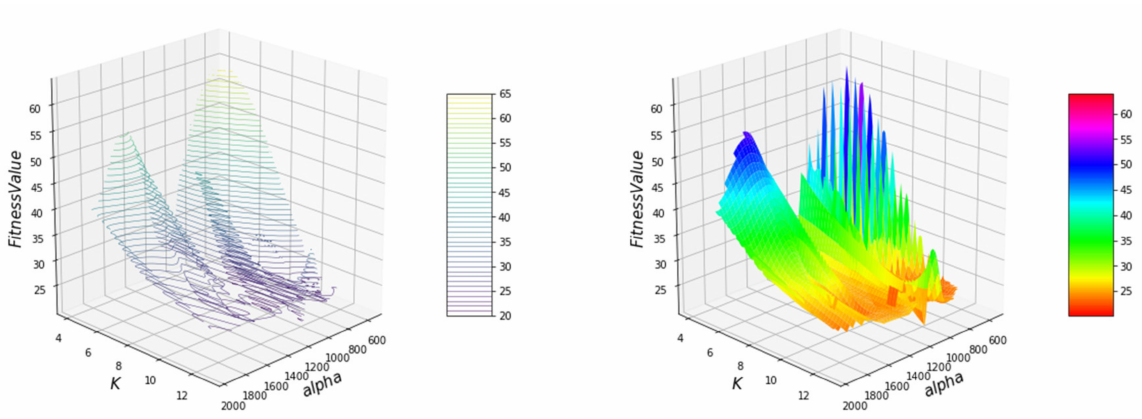
Figure 4. D visualization of the PSO learning